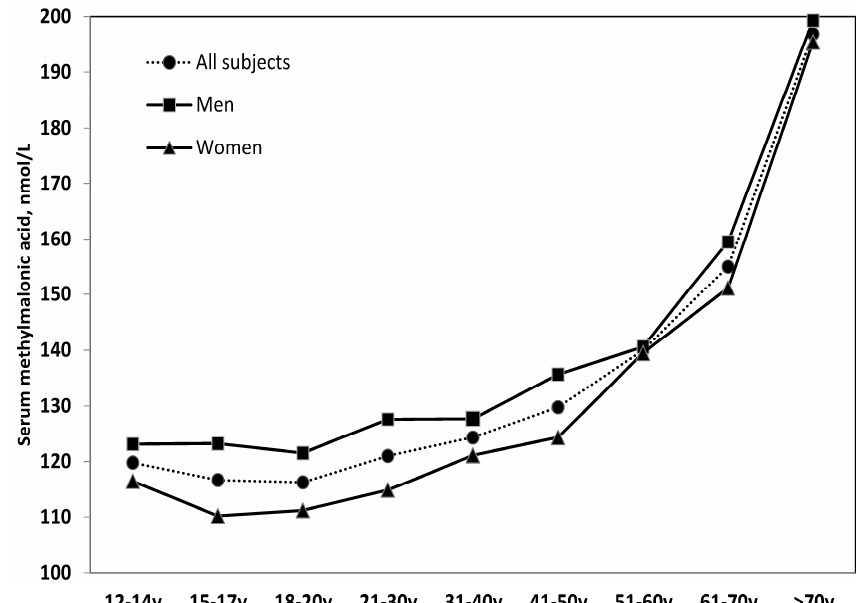
Figure 2. Age-stratified geometric mean concentrations of serum methylmalonic acid (MMA) for ≥ 12 years old persons in the US ( n = 18,569). Values for age were adjusted for sex, race-ethnicity, supplement use, serum creatinine and serum vitamin B-12. Analysis was performed on log MMA concentrations to satisfy normality.